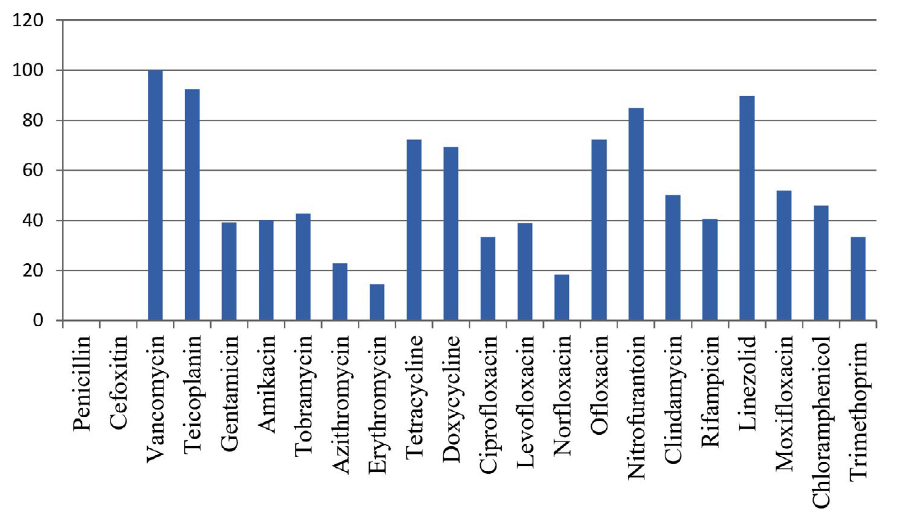
Fig. 3. Age and Sex-Wise Distribution of MRSA Strains.